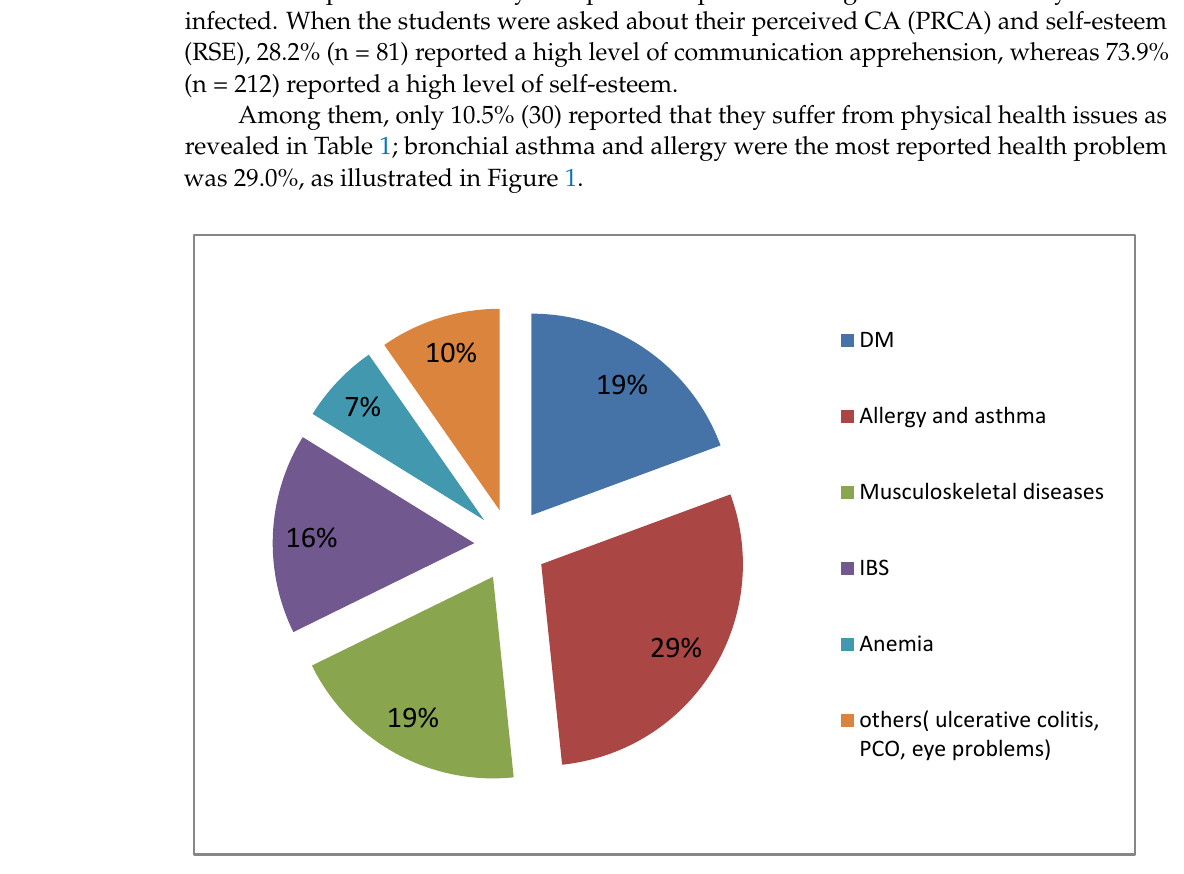
Figure 1. Types of physical issues reported by the sample students (n = 30). On the other hand, around 20% had psychological issues. As displayed in Figure 2, the most frequent psychological problem was anxiety, which was reported by 47.4% of the students, followed by depression, which was reported by 37% of